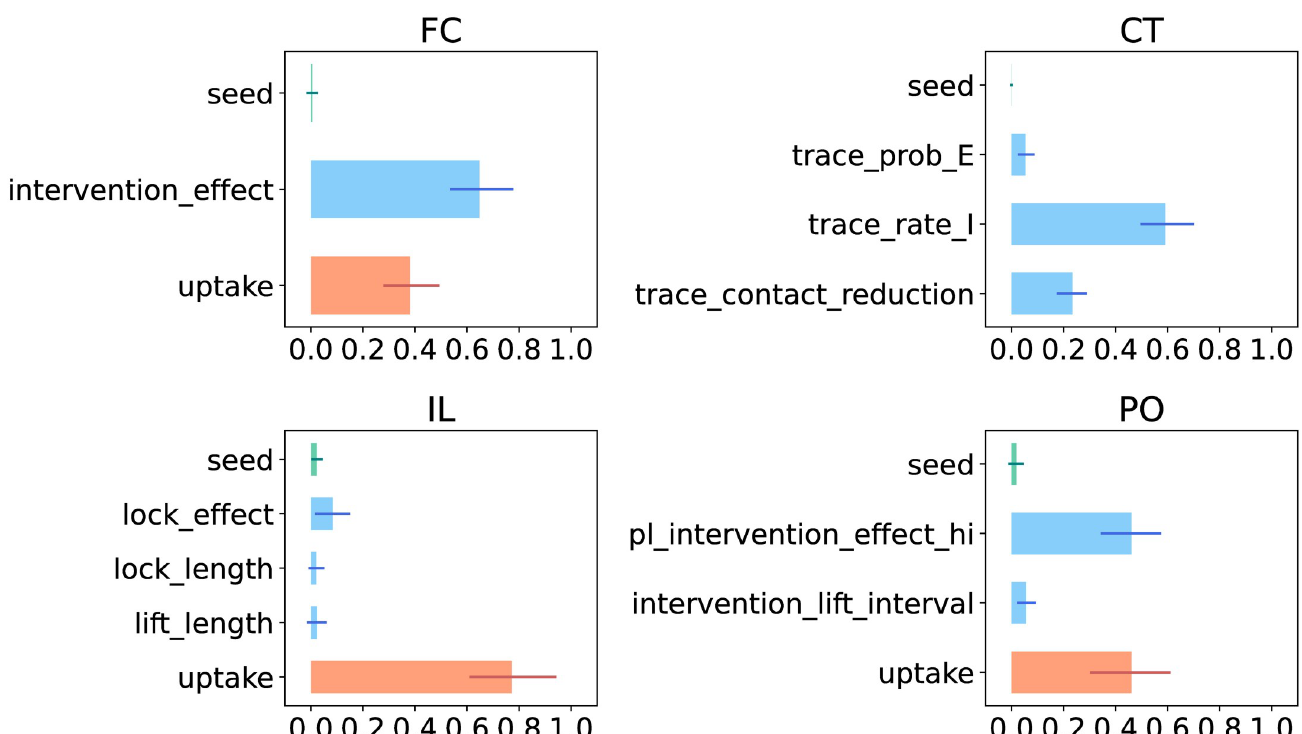
Fig 3. First order Sobol indices of the first QoI (the maximum number of patients in IC). The length of the bars indicate the mean values, while the thinner lines display the 95% confidence interval. We color in orange the uptake parameter, and in green seed .